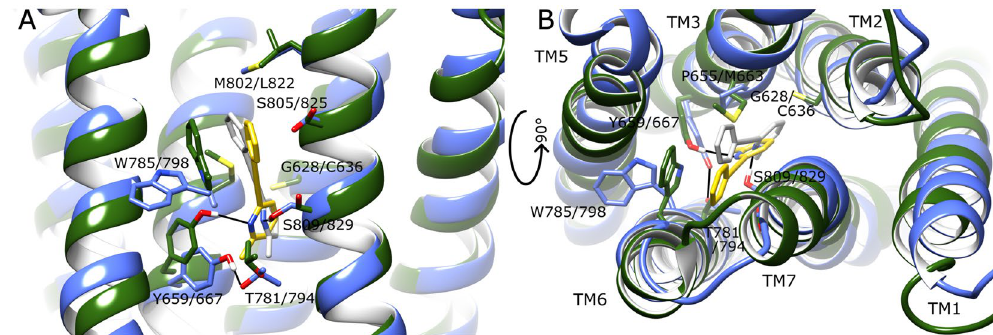
Figure 6. A comparison of average conformations of mGlu4 with bound MPEP (green, yellow, respectively) and mGlu5 with bound MPEP (blue, grey, respectively) from 2.5–5 µ s of respective MD simulations from following perspectives: ( A ) side-view within membrane and ( B ) extracellular top-view. Selected residues delineating allosteric pockets or participating in ligand binding are labelled (mGlu5 first, mGlu4 second). Protein-ligand H-bonds are represented by black